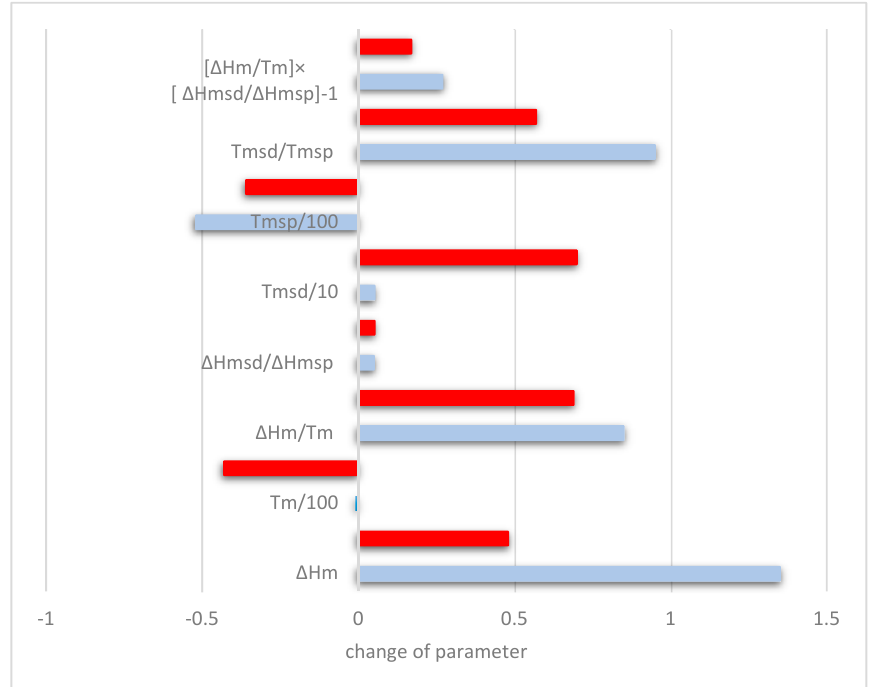
Figure 8. Effect of Al (red) and Cr (blue) on the reduction of macrosegregation of Si. Positive change of parameter value indicates that the addition of Cr or Al increased the specific parameter while reducing MACSi (see text).